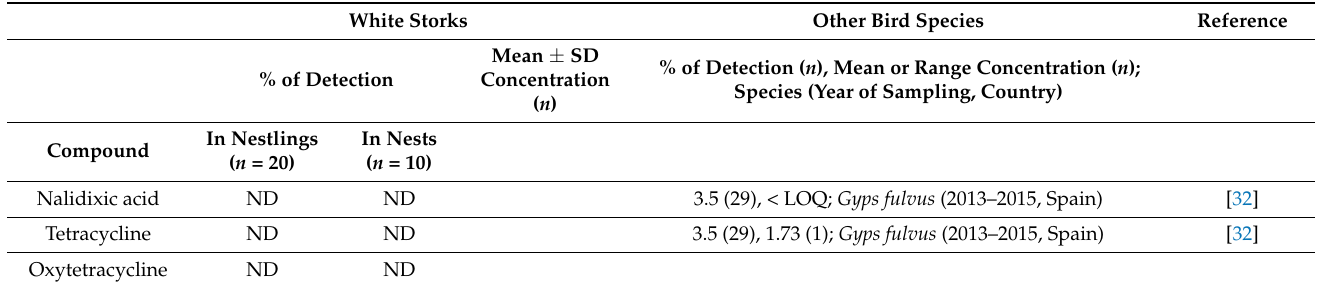
Table 2. Concentrations (ng mL − 1 ) and frequencies of detection (%) of pharmaceuticals found in blood of white stork nestlings, and a review of occurrence in plasma and muscle in other wild birds. ND = not detected; MDL = method detection limits; LOQ = limit of quantification. White Storks Other Bird Species